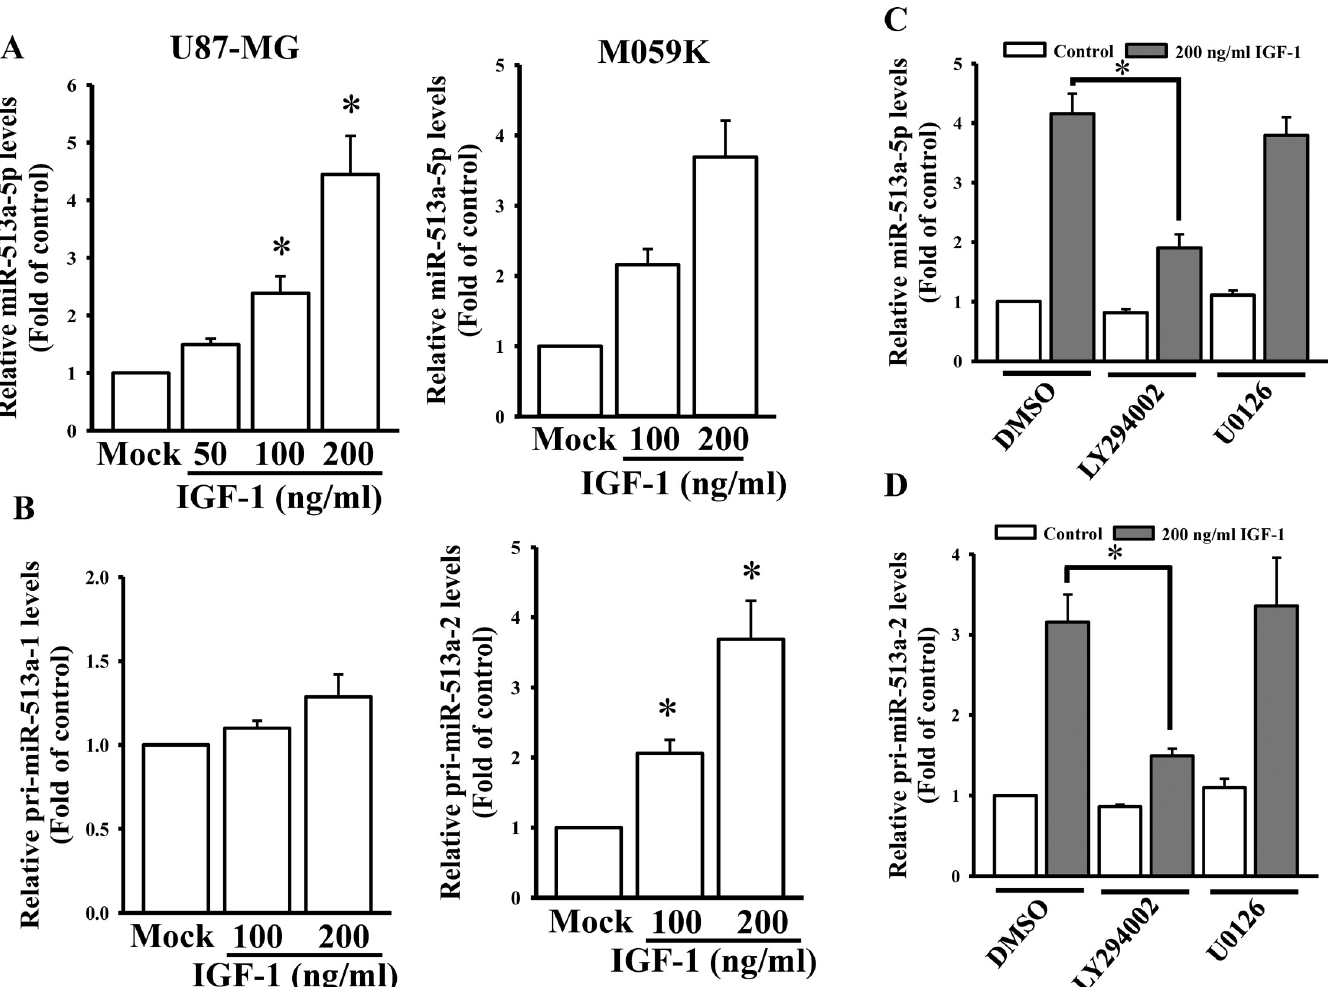
Fig 3. Insulin-like growth factor (IGF)-1 upregulates miR-513a-5p expression from the miR-513a-2 gene via the phosphoinositide 3-kinase (PI3K) pathway. (A) Dose-dependent effects of IGF-1 on miR-513a-5p expression levels in U87-MG and M059K cells. (B) Effects of IGF-1 on primary (pri)-miR-513a-1 and pri-miR-513a-2 levels. The PI3K inhibitor, LY294002, but not the mitogen-activated protein kinase (MAPK) kinase inhibitor, U0126, attenuated IGF-1-stimulated miR-513a-5p (C) and pri-miR-513a-2 (D) levels. After cells were treated with the indicated doses of IGF-1 for 48 h or 200 ng/ml IGF-1 treatment for 48 h and pretreatment with 5 μ M LY294002 and 10 μ M U0126 for 1 h, endogenous miR-513a-5p, pri-miR-513a-1, and pri-miR-513a-2 levels were respectively measured by a real-time PCR. miR-191-5p and GAPDH levels were respectively used as internal controls for the mature and primary miR-513a-5p levels. Data are the mean ± SD of three independent experiments. � p <